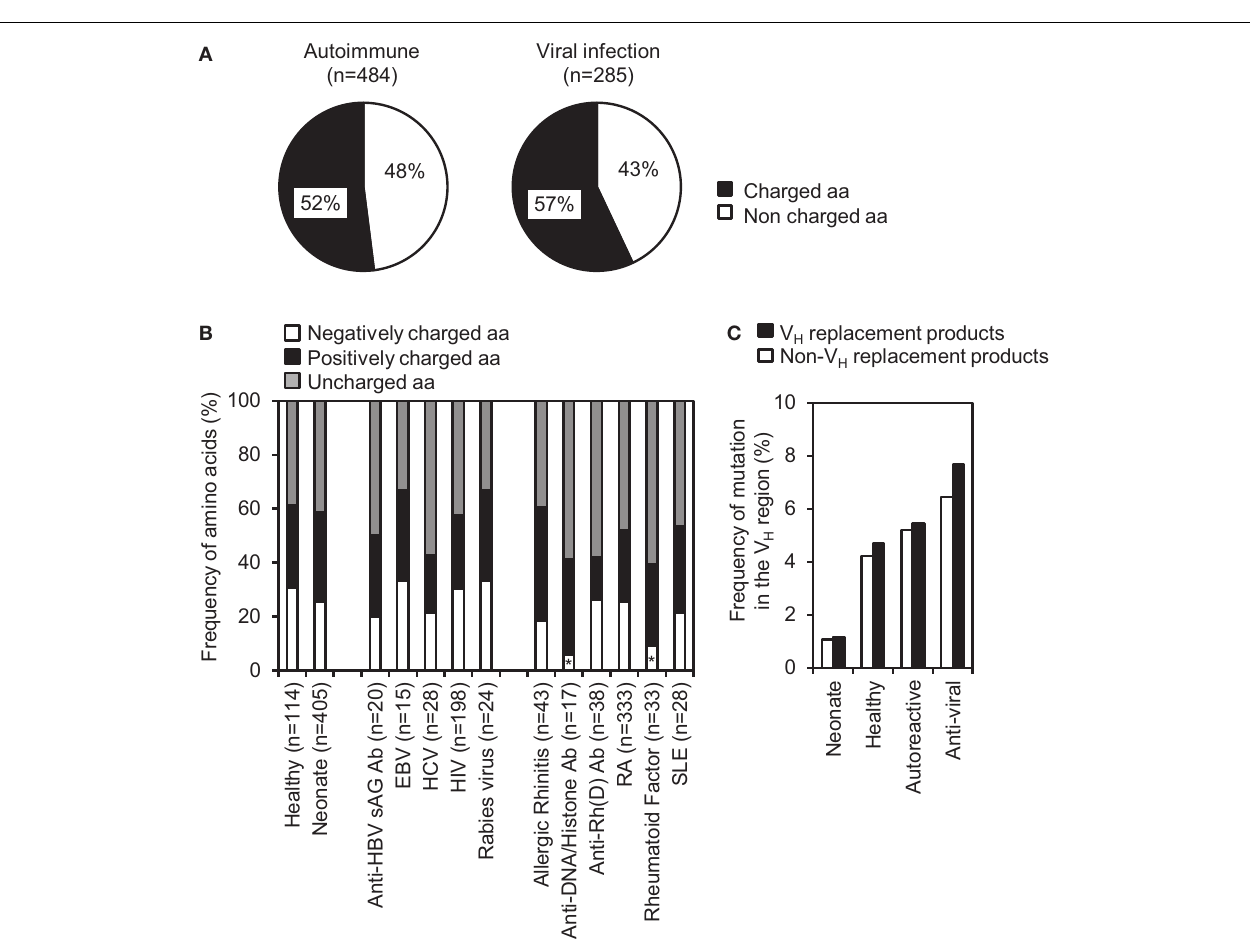
and positively charged residues encoded by theV H replacement footprints in IgH genes derived from autoimmune diseases or viral infections. Statistical significance was determined using a two-tailed Chi square test withYate’s correction. * p < 0.05 is considered statistically significant. (C) Comparison of overall somatic mutation rates (%) withinV H region ofV H replacement products versus non-V H replacement products in different